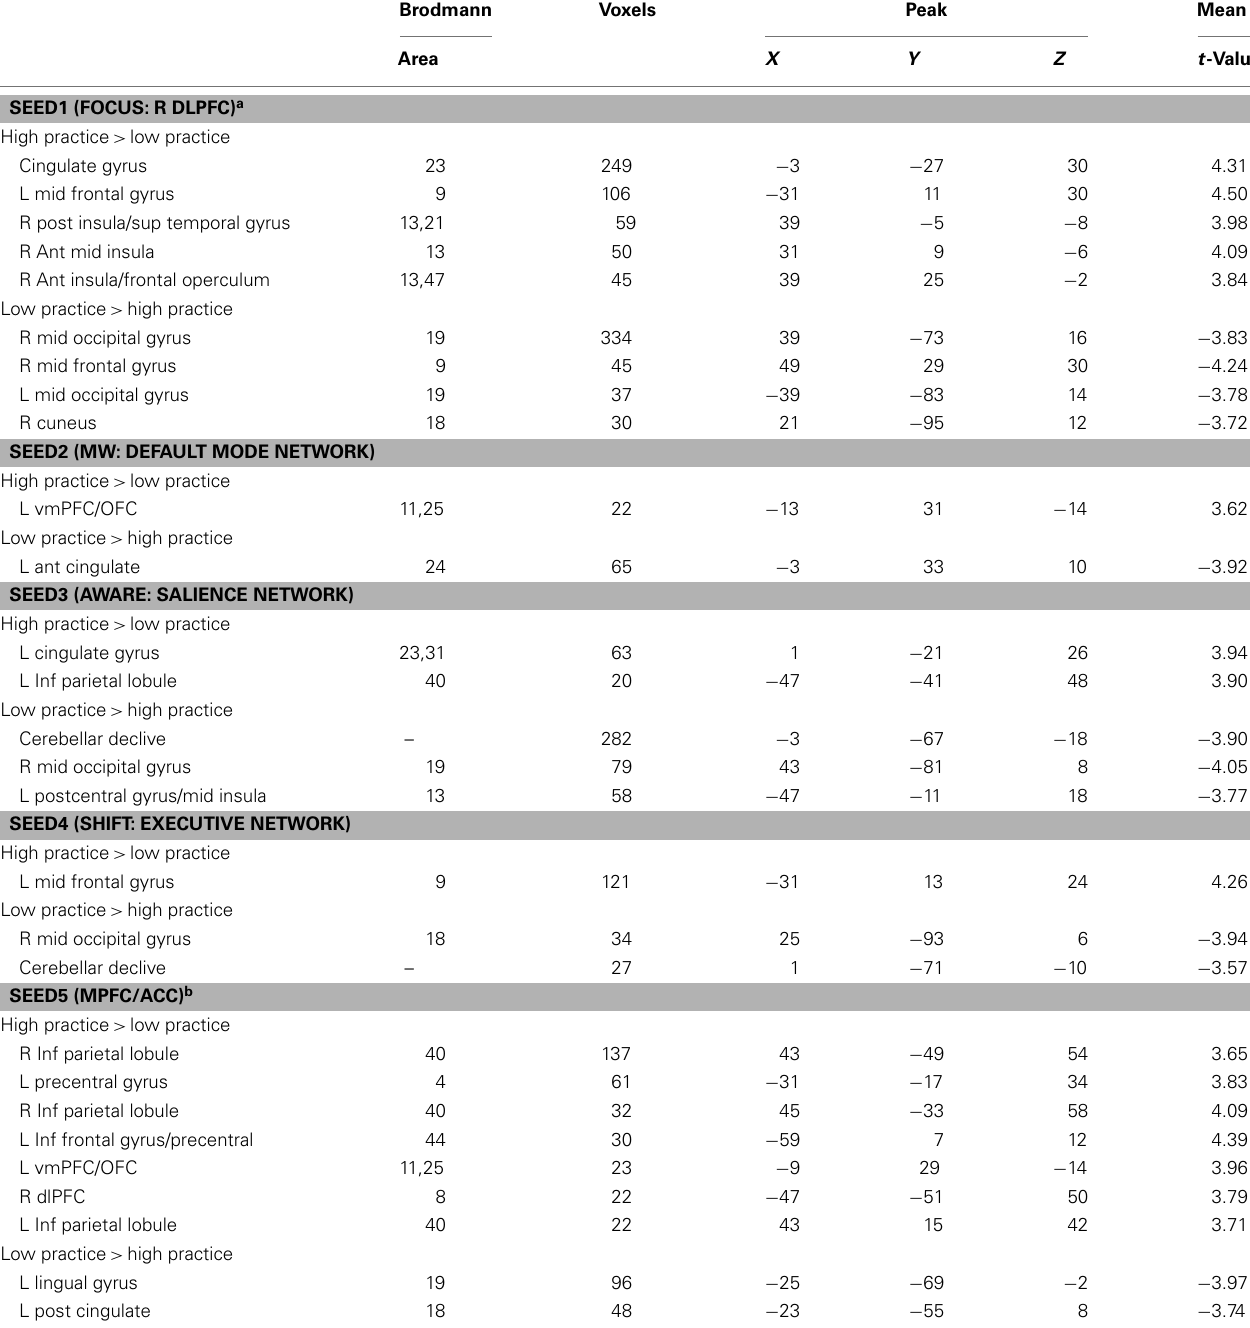
Table 1 | Functional connectivity between